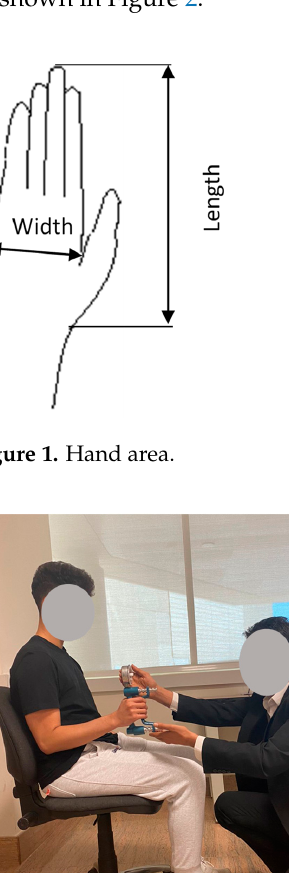
Figure 1. Hand area.